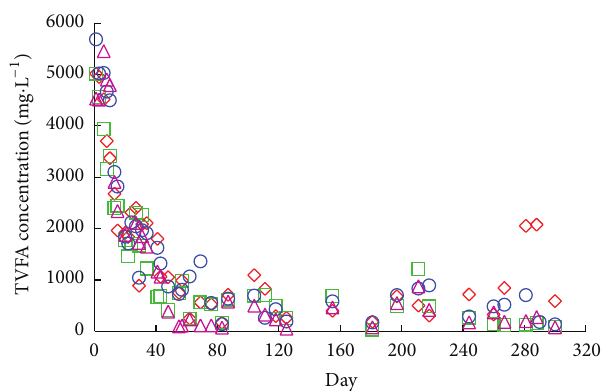
Figure 5: Total solids concentrations in the effluent of all digester = ⬦ ; 𝑅 = I ; systems during the operation period; 𝑅 control- 1 control- 2 = ◻ ; 𝑅 = △ . 𝑅 mixer recycle